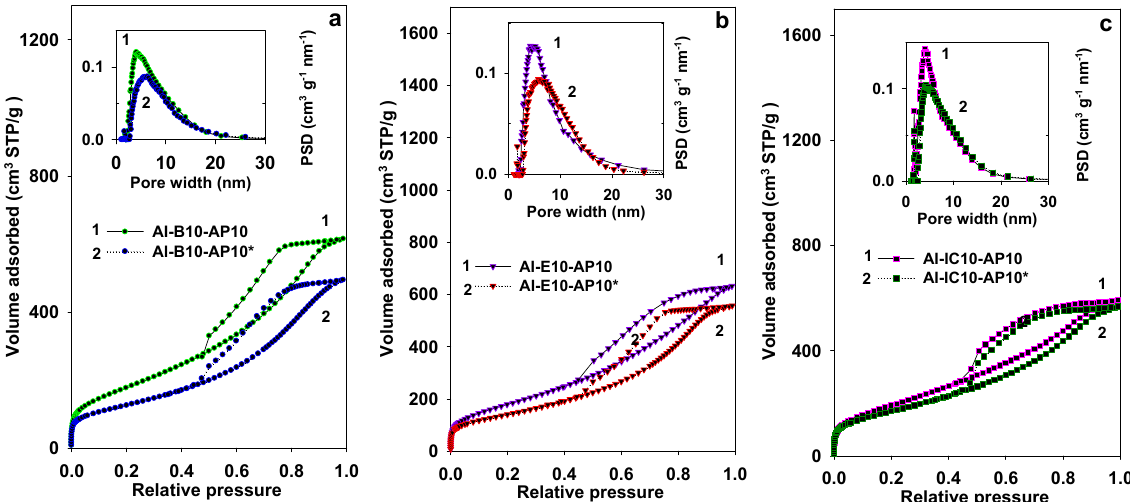
Figure 7. N 2 adsorption isotherms (left panel) and the corresponding PSD curves (insets) for the